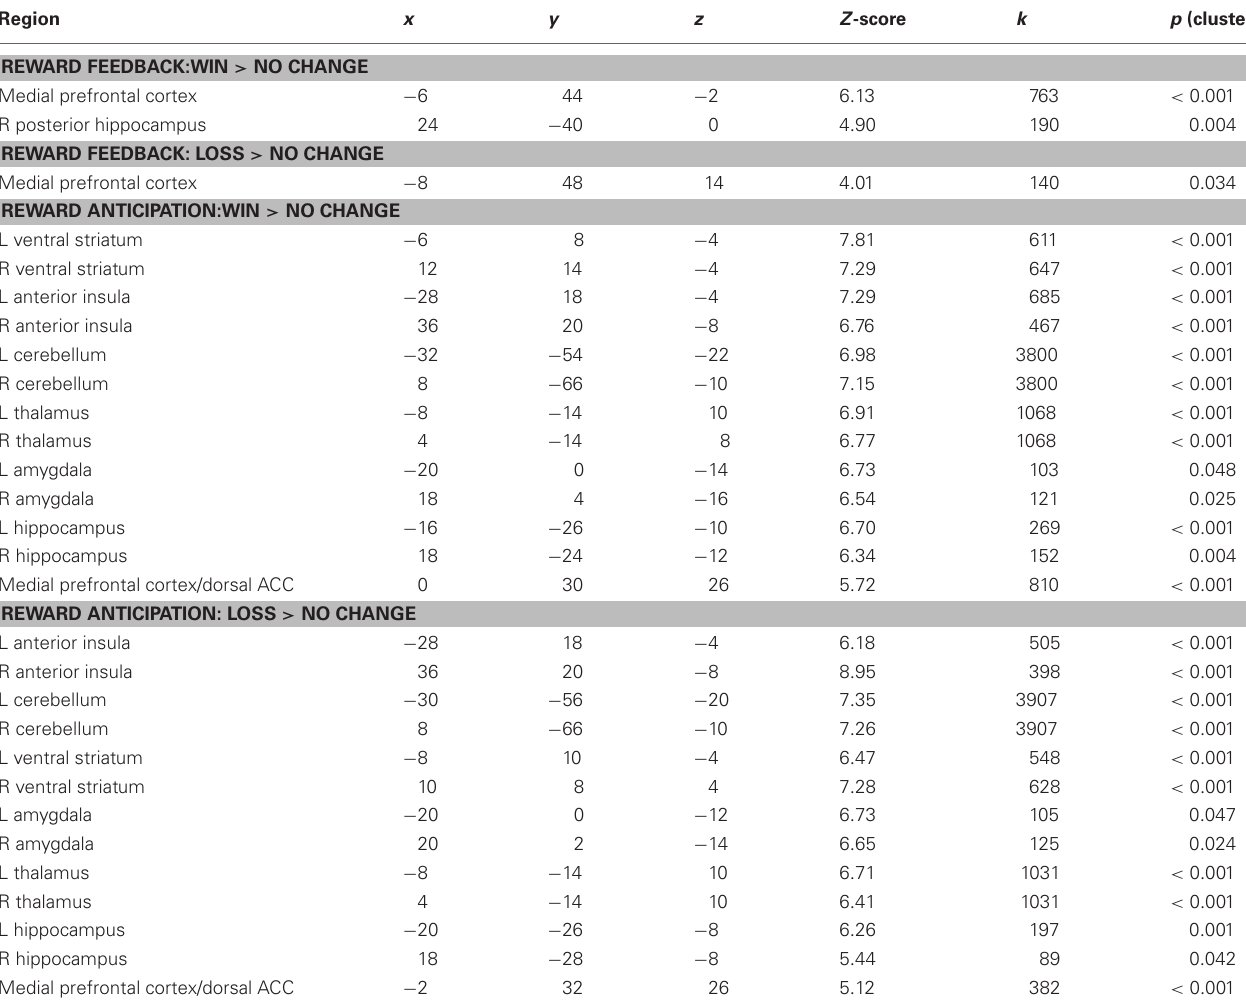
Table 1 | Brain regions activated during reward anticipation and feedback conditions of the MID task. Region x y z Z -score k p (cluster)